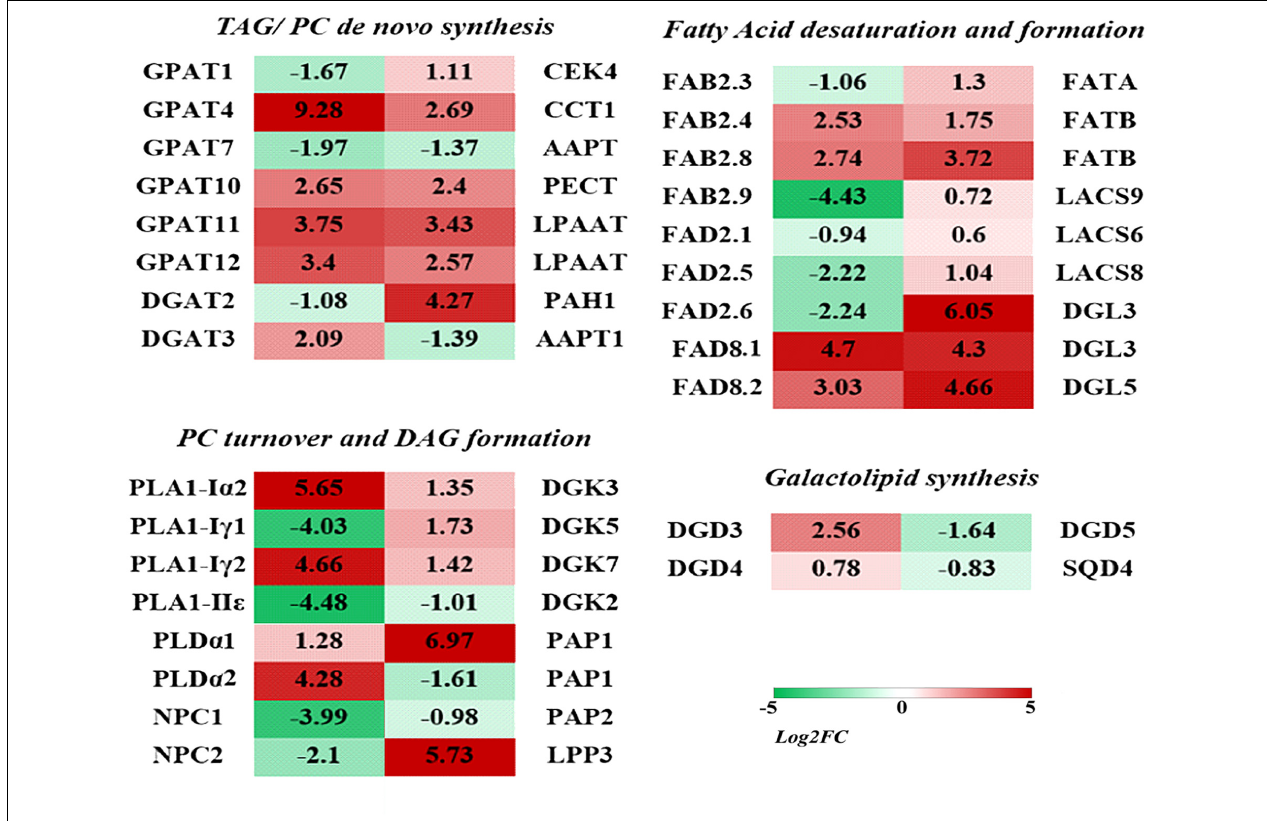
FIGURE 6 | Differentially expressed genes (DEGs) involved in major lipid metabolism pathways in maize roots under cold stress (5 ◦ C). The heatmaps were constructed to illustrate the differential expression profiles of significant lipid related DEGs. The number in each color block represents the Log2(fold-change) of the corresponding genes, and the negative number represents down-regulated DEGs. The color scale was provided. Red color indicates higher expression level, and green color indicates lower expression